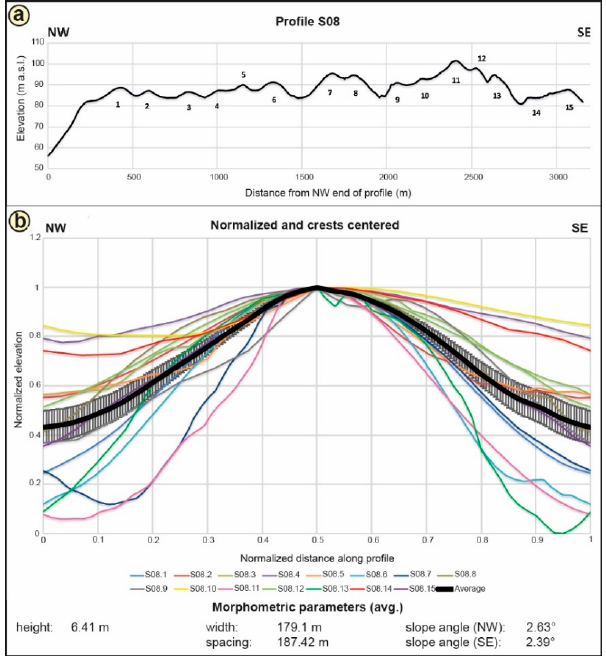
Figure 7. Profile S08 is shown as elevation profile from its distal (NW) to proximal (SE) end with the numbered ridge crests ( a ); The stacked profiles of the elevation profile include the average graph (thick black graph) and error bars (±1 standard deviation) ( b ). The morphometric parameters—mean height, width, spacing, and slope angles—are shown below.